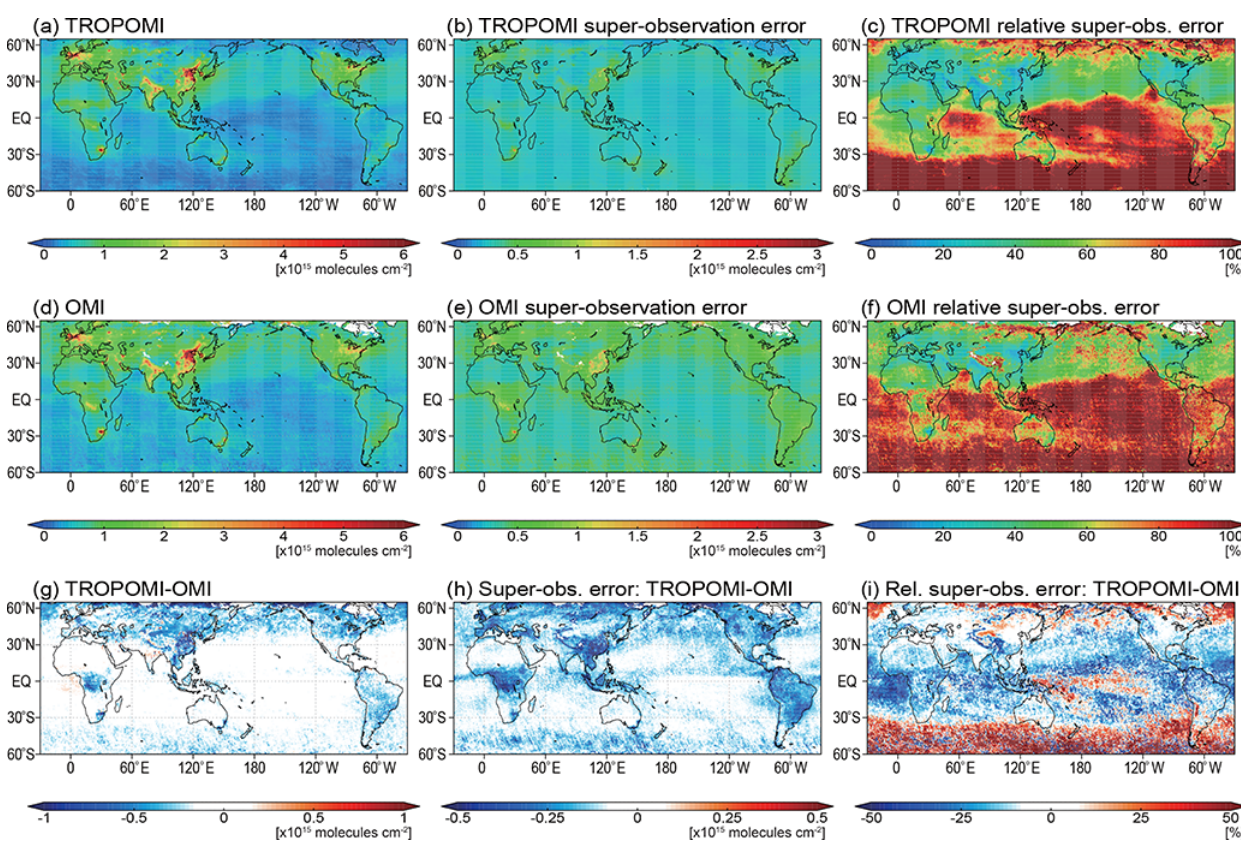
Figure 1. Global distribution of tropospheric NO 2 column (a, d, g) , super-observation errors (b, e, h) , and relative super-observation er- rors (c, f, i) obtained from the Tropospheric Monitoring Instrument (TROPOMI; a–c ) and the Ozone Monitoring Instrument (OMI; d– f ) from April–May 2018, as well as the differences between TROPOMI and OMI (g–i) . The values are mapped onto 0.56 ◦ resolution grids. The units of the tropospheric NO 2 column, super-observation errors, and relative super-observation errors are × 10 15 molec.cm − 2 , × 10 15 molec.cm − 2 , and percentage (%), respectively. Table 2. Mean tropospheric NO 2 column ( × 10 − 15 molec.cm − 2 ), super-observation error ( × 10 − 15 molec.cm − 2 ), relative super-observation error (%) over 60 ◦ S–60 ◦ N in the Tropospheric Monitoring Instrument (TROPOMI) from April to May 2018, and the Ozone Monitoring Instrument (OMI) from April to May in 2005 and 2018. Values in brackets are calculated from TROPOMI and OMI data with co-location criteria of < 60km in space and < 2h in